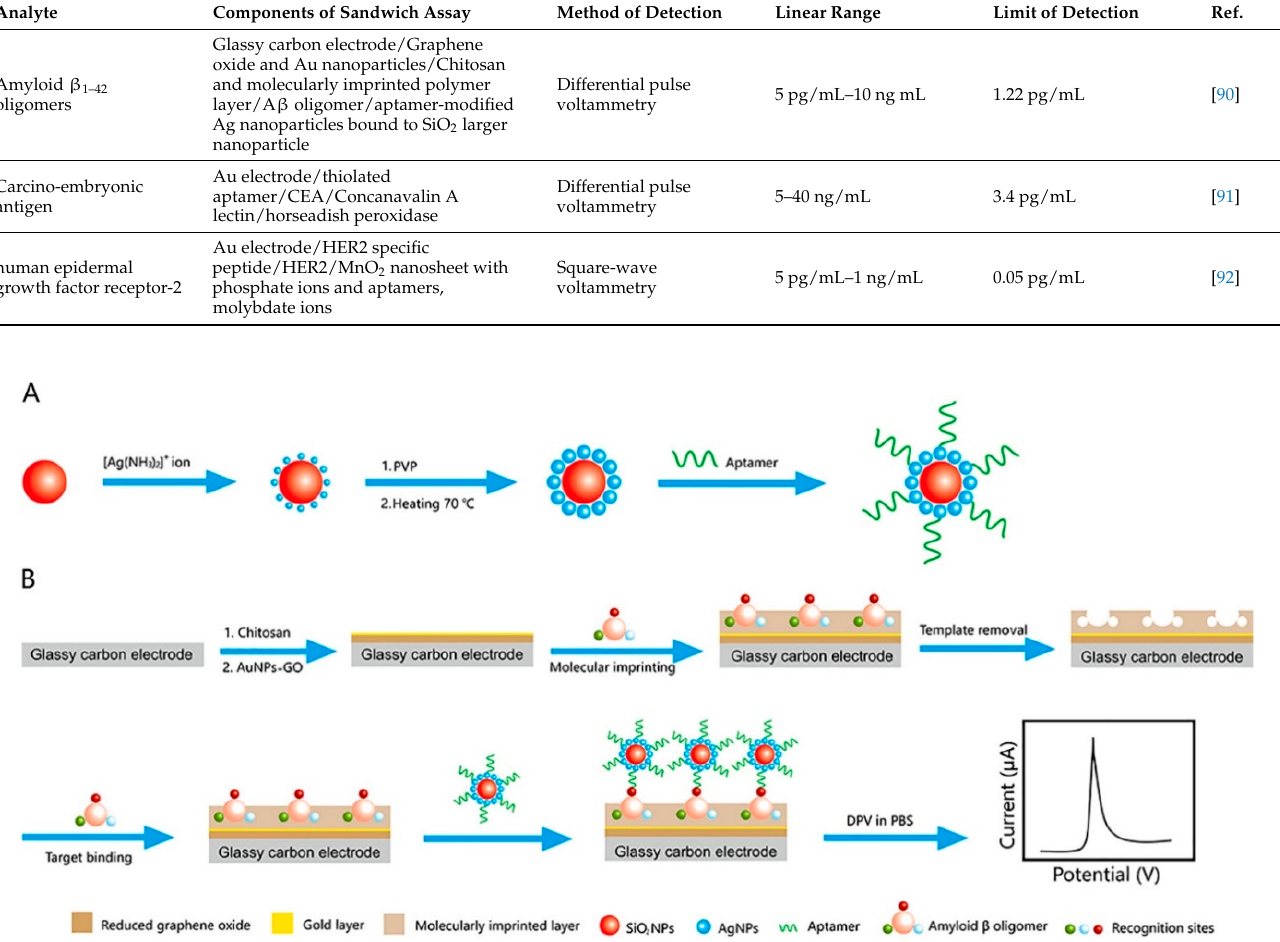
Figure 9. Schematic illustration of ( A ) the preparation of the SiO 2 @Ag-aptamer composite, and ( B ) the fabrication of the MIPs-based antibody-free biosensor and the electrochemical detection of A β oligomer via a sandwich-type assay. Reprinted with permission from reference [90]. Copyright 2020, Elsevier.